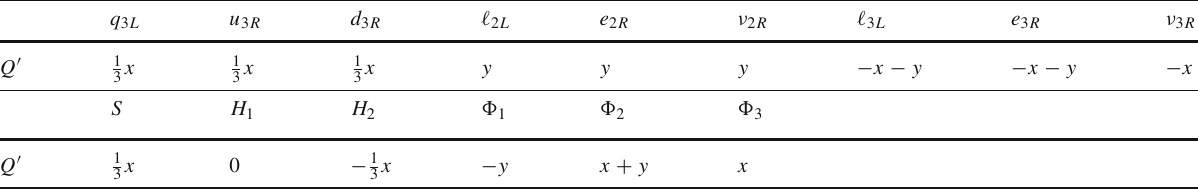
Table 1 U ( 1 ) (cid:2) charges of fermions and